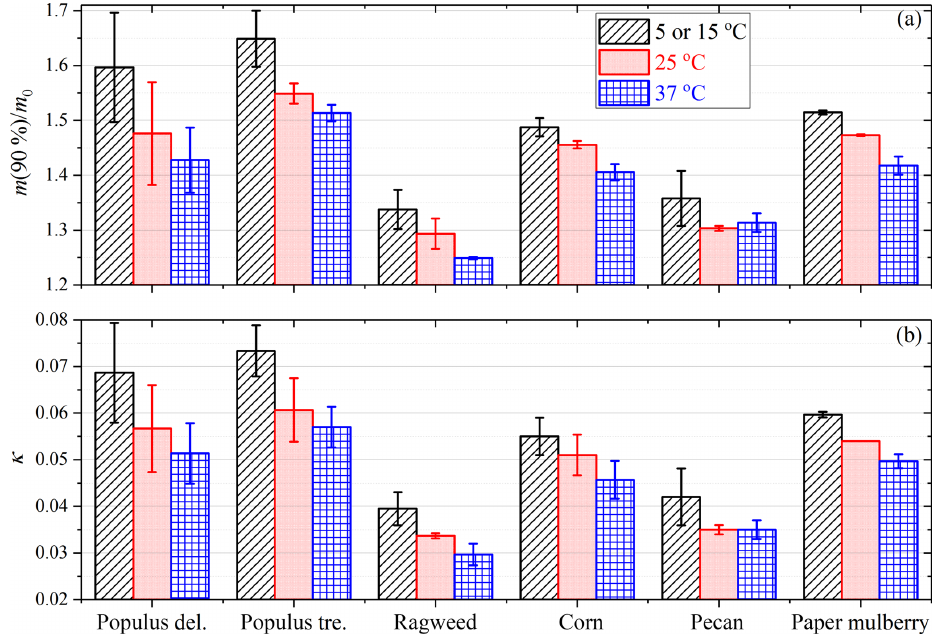
Figure 5. Measured ratios of sample mass at 90%RH to that at < 1%RH (a) and derived κ values (b) for six pollen species at different temperatures. The lowest temperatures were 5 ◦ C for Populus deltoides ( P. deltoides ), Populus tremuloides ( P. tremuloides ) and ragweed pollen, and 15 ◦ C for corn, pecan and paper mulberry pollen.